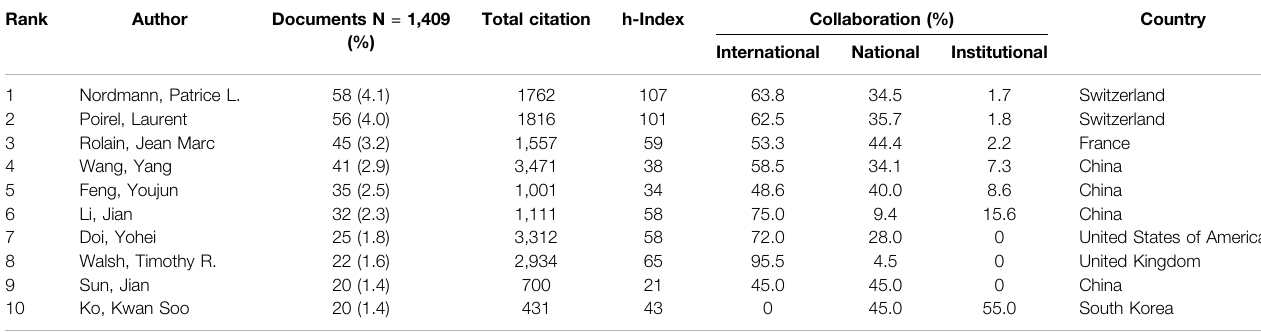
TABLE 3 | Top ten authors publishing on polymyxin resistance (2010 – 2019).